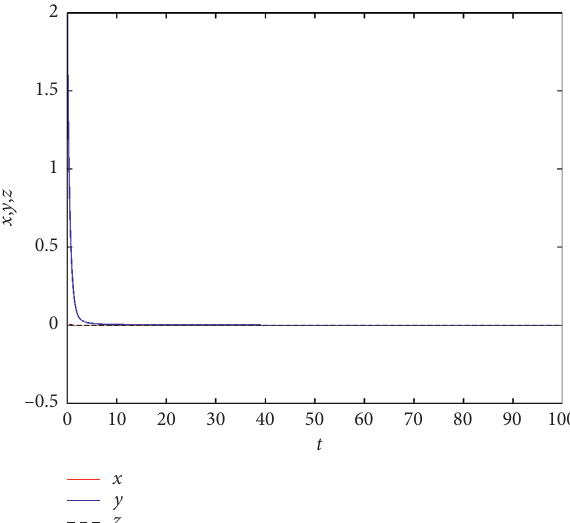
Figure 4: Trajectories of chaotic FOS system (32) converge to the origin steady state using a � 0 . 4 ,b � 0 . 175 ,c � 0 . 4 , and α � 0 . 96 � 1 ,k � 2 , and k � and the FCGs k 1 2 3